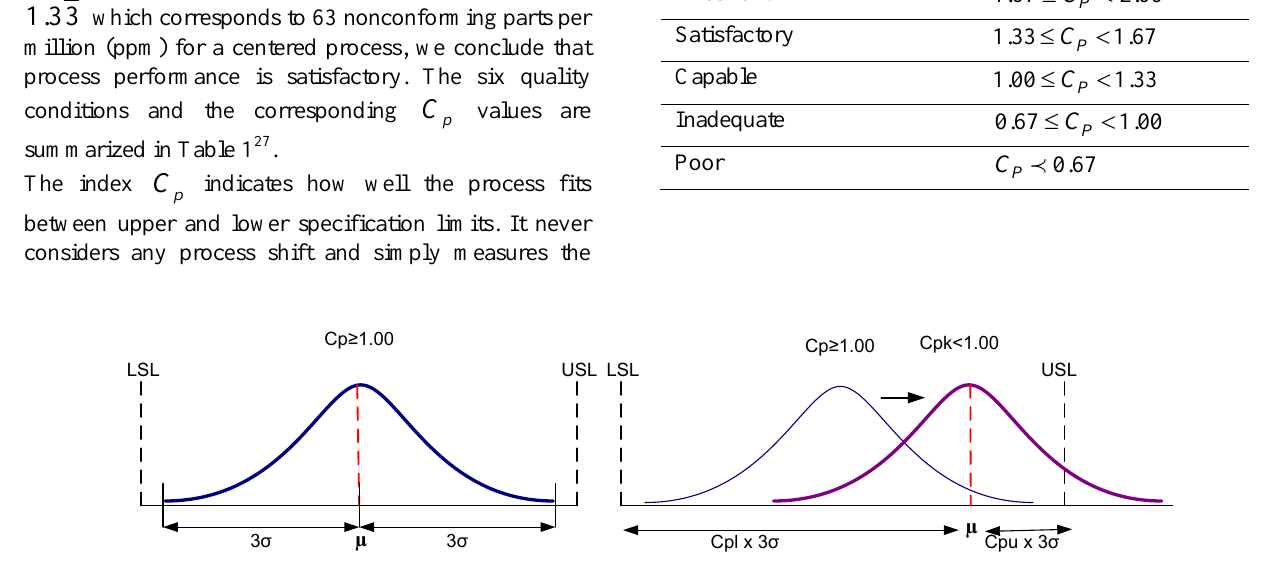
Figure 1 Process location and the indices C